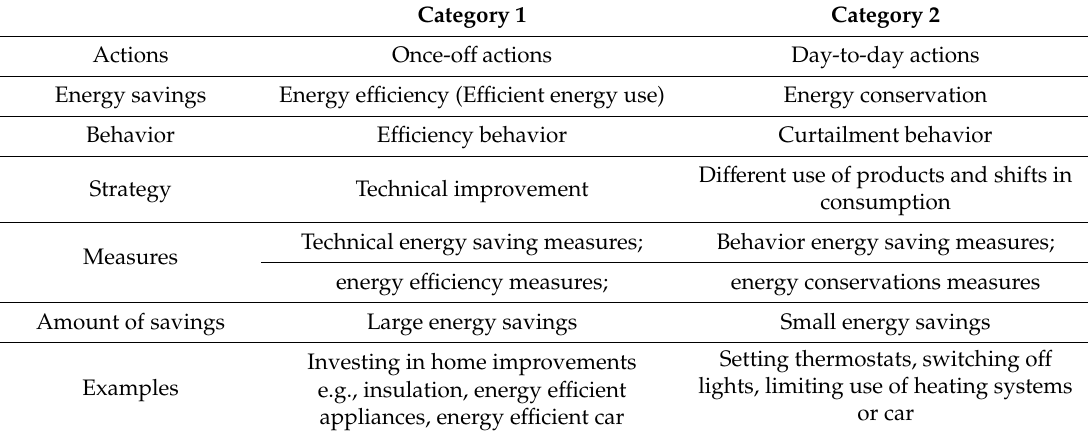
Table 1. Energy consumption of